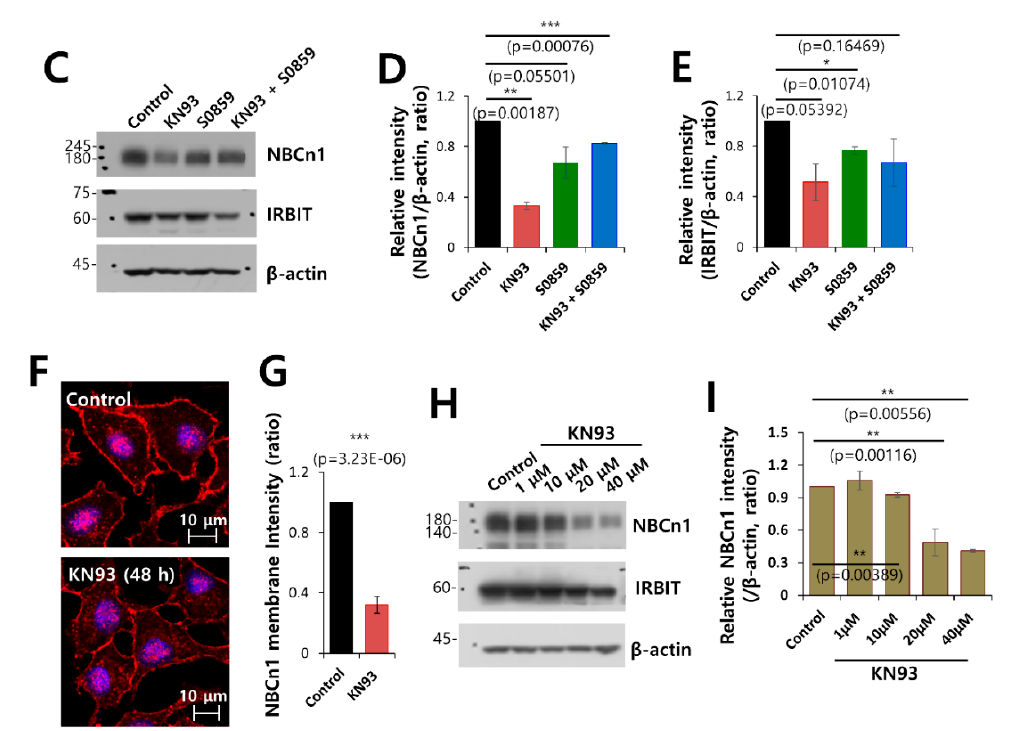
Figure 7. Combined inhibition of CaMKII and NBC markedly inhibited cell migration. ( A ) Migration of A549 cells was measured by a transwell membrane migration assay. The cells were incubated with the medium and reagents indicated hereafter (bottom chamber: media of pH 6.5; upper chamber: pretreatment with KN93 and S0859 at 48 h). Immunofluorescence staining with DAPI (blue). The scale bars represent 50 µ m. ( B ) Analysis of the total intensity of DAPI for determination of A549 migration. The bars represent the mean ± SEM of data ( n = 4). ( C ) Protein expression of IRBIT and NBCn1 in A549 cells in the presence of KN93 and S0859 at 20 µ M. β -Actin was used as a loading control. ( D ) Analysis of the relative intensity of NBCn1. The bars indicate the mean ± SEM of the intensities of NBCn1 normalized by β -Actin ( n = 3). ( E ) Analysis of the relative intensity of IRBIT. The bars indicate the mean ± SEM of the intensities of IRBIT normalized by β -Actin ( n = 3). ( F ) Immunostaining images of NBCn1 (red) and nucleus (DAPI, blue) in the presence or absence of 20 µ M KN93. Scale bars of the magnified images represent 10 µ m. ( G ) The bars indicate the mean ± SEM of the NBCn1 membrane determined from three experimental replicates ( n = 3). ( H ) Protein expression of IRBIT and NBCn1 in A549 cells in the presence of KN93 at 1–40 µ M. β -Actin was used as a loading control. ( I ) Analysis of the relative intensity of NBCn1. The bars indicate the mean ± SEM of the intensities of NBCn1 normalized by β -Actin ( n =